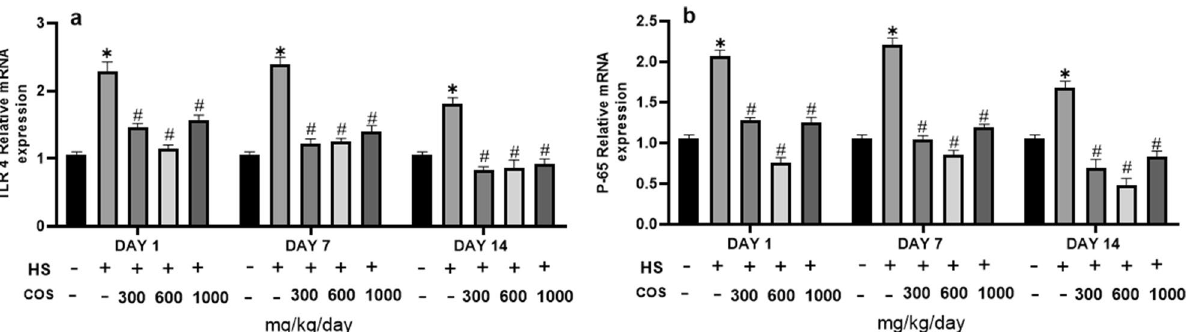
Figure 10. Effects of chitosan on protein expression. ( a ) TLR4 ( b ) NF-κB . Control: normal mice; HS: Heat stress mice; COS-L: mice treated with HS plus COS (300 mg/kg); COS-M: mice treated with HS plus COS (600 mg/kg); COS-H: mice treated with HS plus COS (1000 mg/kg). Data are expressed as mean ± standard error. *Indicates p < 0.05 compared with the blank control group, # Indicates p < 0.05 compared with the HS control